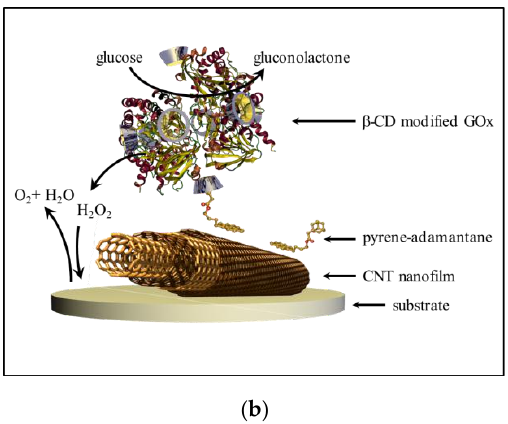
Figure 1. Diagrams showing: ( a ) method of flotation assembly followed by transfer onto an electrode substrate; and ( b ) constructed enzymatic interface consisting of Pt-MWCNTs/pyAd/β-CD-GOx.